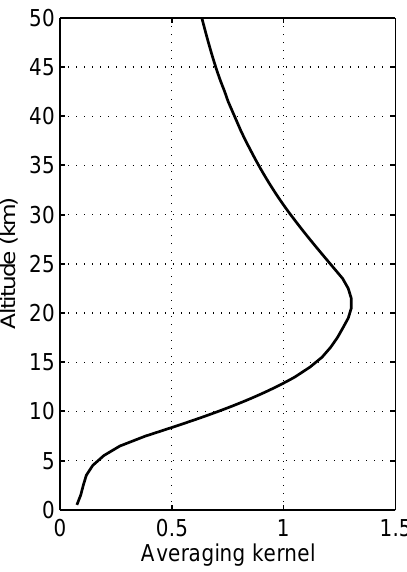
Fig. 1. Column averaging kernel (left plot) computed for 90 ◦ SZA in zenith-sky geometry using the ozone and temperature profiles corresponding to 45 ◦ N/325DU in June extracted from the TOMS V8 zonal mean climatology. The wavelength is fixed to